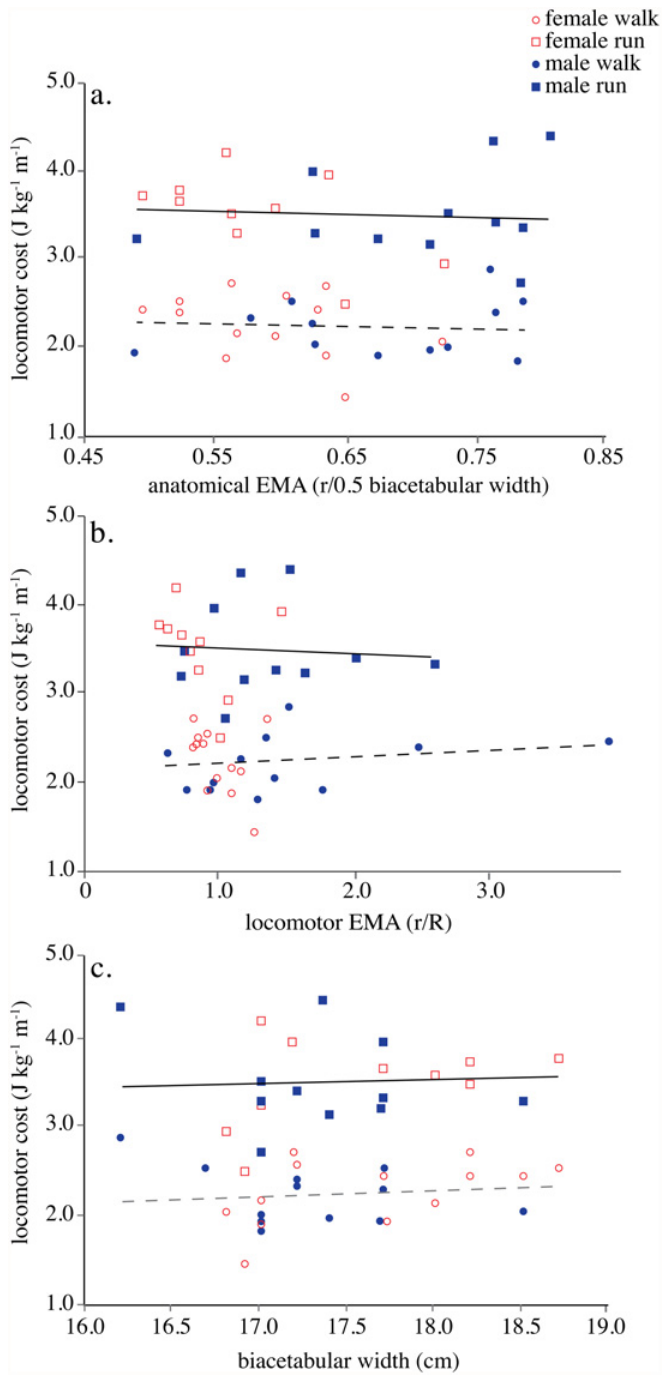
Fig 2. Hip abductor EMA measured anatomically and dynamically versus locomotor cost. a. Locomotor cost versus anatomical EMA derived from the static model at a walk (y = -0.29x + 2.43, R 2 = 0.006, P = 0.71) and a run (y = -0.35x + 3.73, R 2 = 0.005, P = 0.75). b. Locomotor cost versus locomotor EMA determined dynamically at a walk (y = -0.07x + 2.15, R 2 = 0.02, P = 0.49) and a run (y = -0.06x + 3.57, R 2 = 0.004, P = 0.77). c. Biacetabular width versus locomotor cost at a walk (y = 6.85x + 1.04, R 2 = 0.02, P = 0.54) and a run (y = 4.52x + 2.71, R 2 = 0.003, P = 0.81). Lines indicate ordinary LSR (walk, n = 25; run, n = 21).